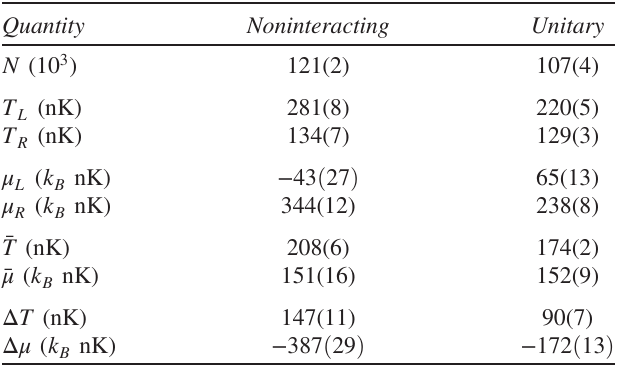
TABLE I. Reservoir conditions for measuring thermoelectricity in the noninteracting and strongly interacting regimes. The values are averaged over the realizations at different gate potentials, and their uncertainties indicate one standard